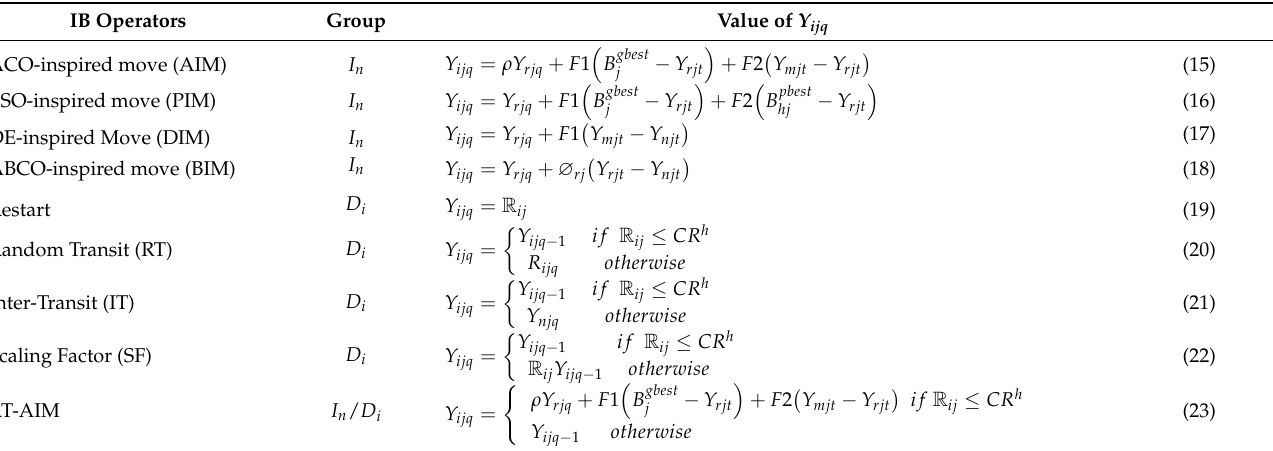
Table 3. Intelligence box details